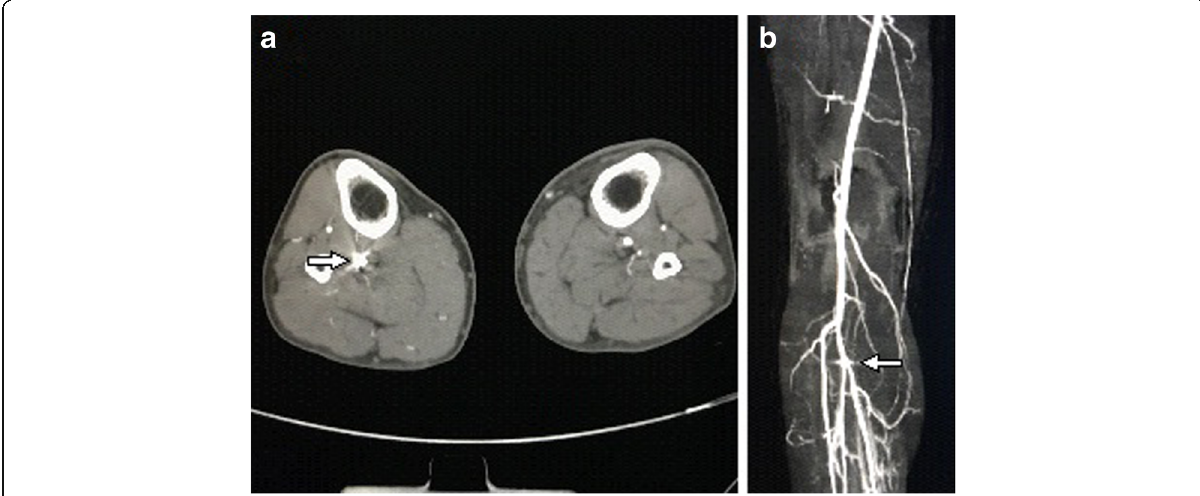
Fig. 1 a Computed tomography (CT) angiogram axial view of the lower limbs. The arrow points to an artifact occluding the right TPT. b CT angiogram coronal view of the right lower limb. The arrow points to an artifact occluding the right